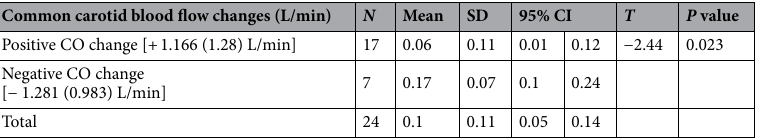
Table 3. Comparison of carotid blood flow changes according to CO changes between T 0 and T 1 . CO, cardiac output; SD, standard deviation; CI, confidence interval.